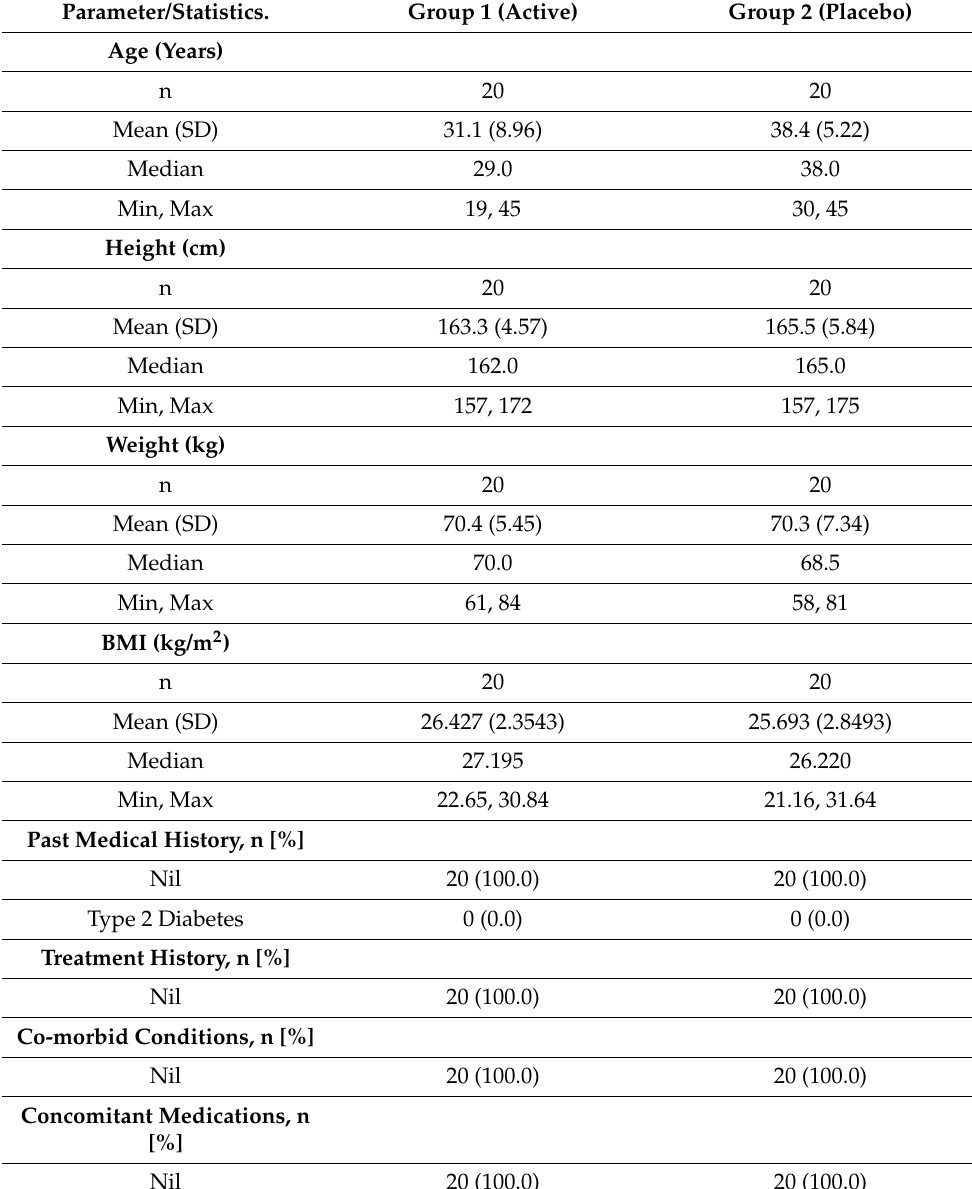
Table 1. Demographics characteristics of the two